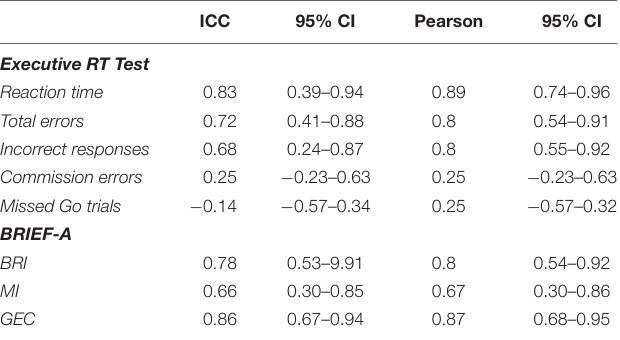
TABLE 3 | The test–retest ICC and Pearson’s correlation coefficients with 95% confidence